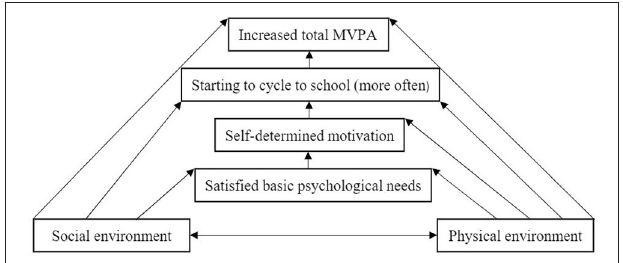
FIGURE 3 | Logic model of change [modified according to (21) (p. 67)]. MVPA, moderate-to-vigorous physical